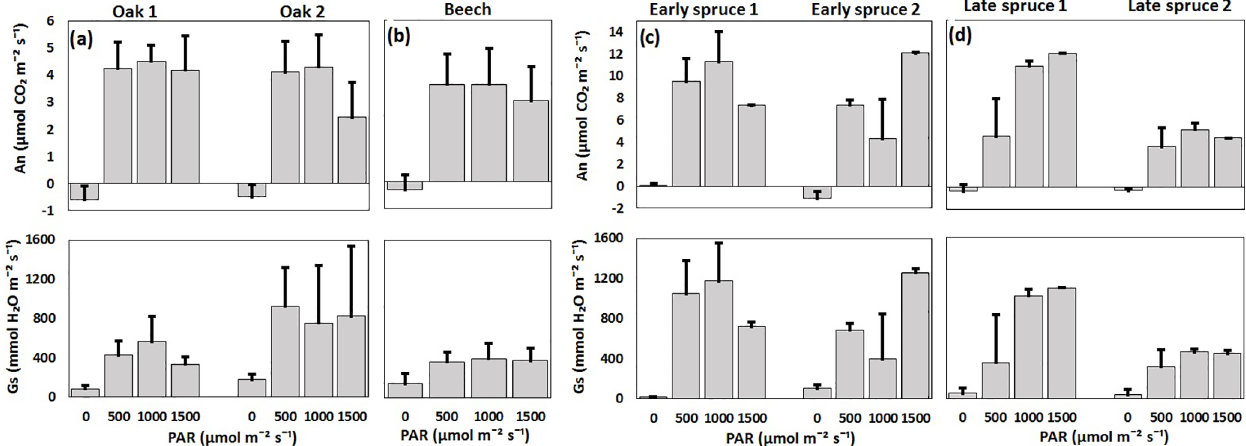
Figure 4. The net assimilation rate ( A n ) and stomatal conductance ( G S , mmol H 2 Om − 2 s − 1 ) of (a) two individuals of English oak, (b) Eu- ropean beech, (c) two individuals of Norway spruce with an early budburst (early spruce) and (d) two individuals of Norway spruce with a late budburst (late spruce). The values are averages ± SD ( n = 13–21). Table 1. The P values from repeated measures ANOVA tests on the emission rate of each compound, photosynthetic rates ( A n ) and stomatal conductance ( G S ) in response to an increase in light intensity. The trees that were measured were two individuals of English oak ( Quercus robur ), one European beech ( Fagus sylvatica ), two individuals of Norway spruce ( Picea abies ) with an early budburst (early spruce) and two individuals of Norway spruce with a late budburst (late spruce). P values marked in bold show statistically significant values ( P < 0 . 05). Isoprene was not detected from the European beech tree. Compound Oak 1 Oak 2 Beech Early spruce